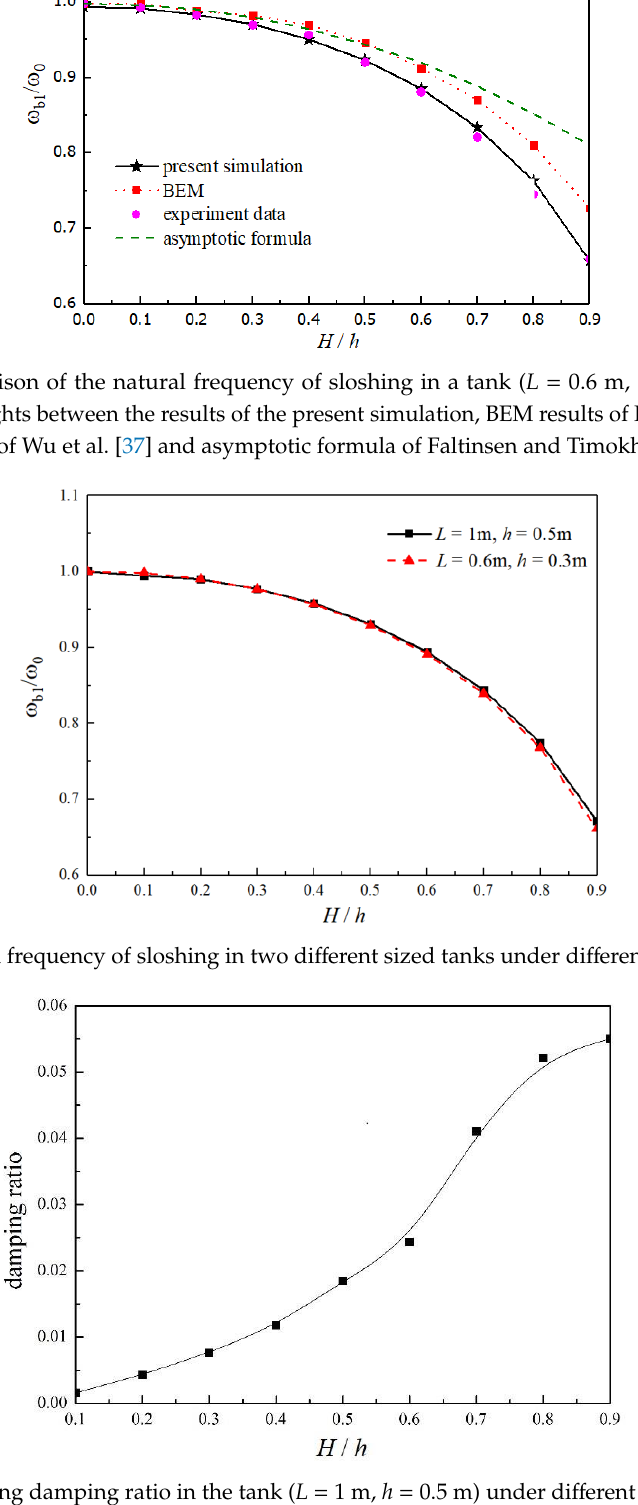
depth. In Figure 11, the time series of free surface elevations in the clean tank exhibited a distinct resonance wave characteristic. The free surface elevations decreased significantly with the increase of the baffle height. Figure 10. The maximum elevation of free surface at y = 0 and y = 0.5 L of sloshing in the tank under different baffle heights.